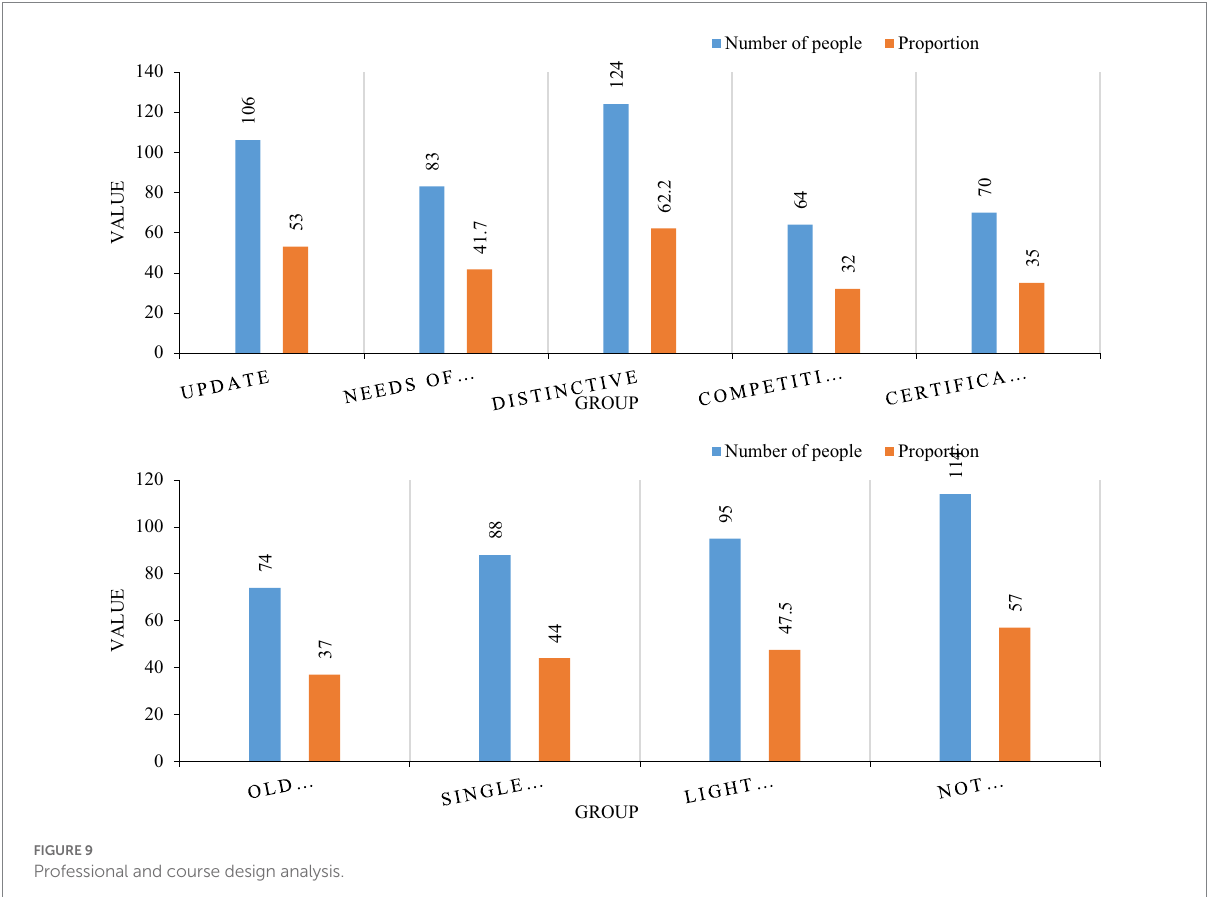
FIGURE 9 Professional and course design